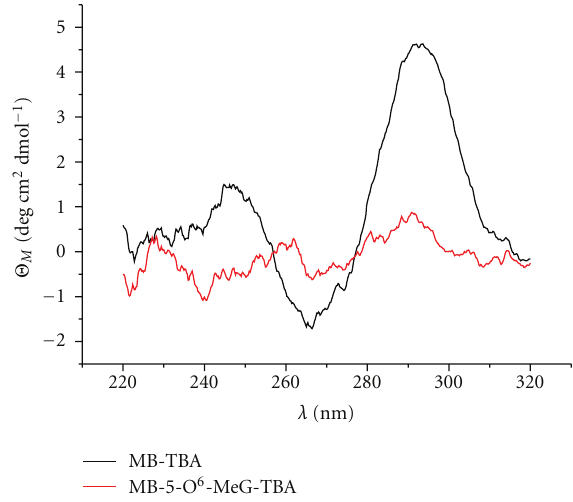
Figure 2: CD spectra of MB-TBA and MB-5-O 6 -MeG-TBA at 25 ◦ C. Bu ff er conditions: 10 mM sodium cacodylate pH 7.0 and 100 mM KCl, sample concentration 1 μ